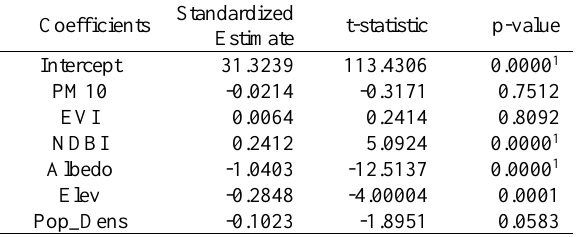
Table 4. 10 th quantile regression results.